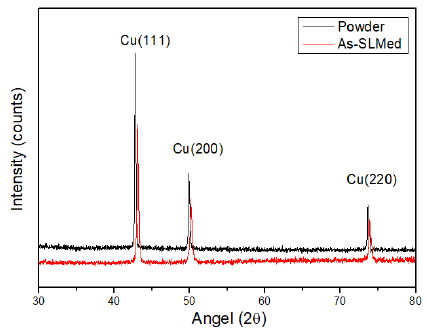
Figure 5. XRD patterns of the Cu–Cr–Zr raw alloy powder and as-built SLM alloy.